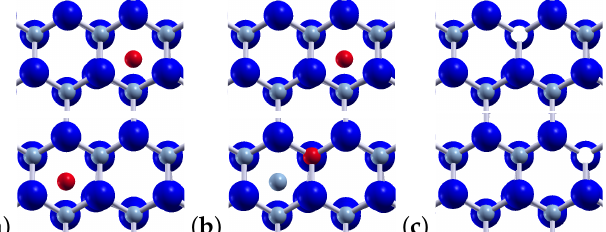
Figure 2. Diffusion mechanisms: ( a ) direct interstitial; ( b ) indirect interstitial; ( c ) vacancy mediated. Each top panel represents an initial site of defect migration, while the bottom one—a final site. Large navy blue balls represent Al atoms, small blue—N, red—interstitial N, and white—nitrogen vacancy V N